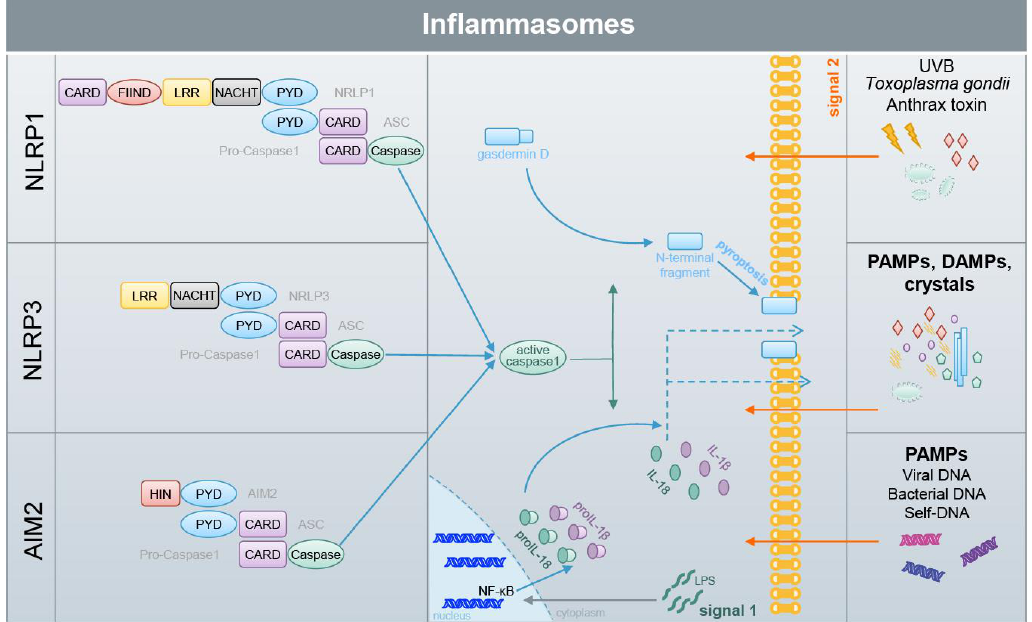
Figure 5. Inflammasomes are activated by different stress factors. NLRP1, NLRP3 and AIM2 represent important inflammasome sensor proteins, which consist of di ff erent domains. Upon detection